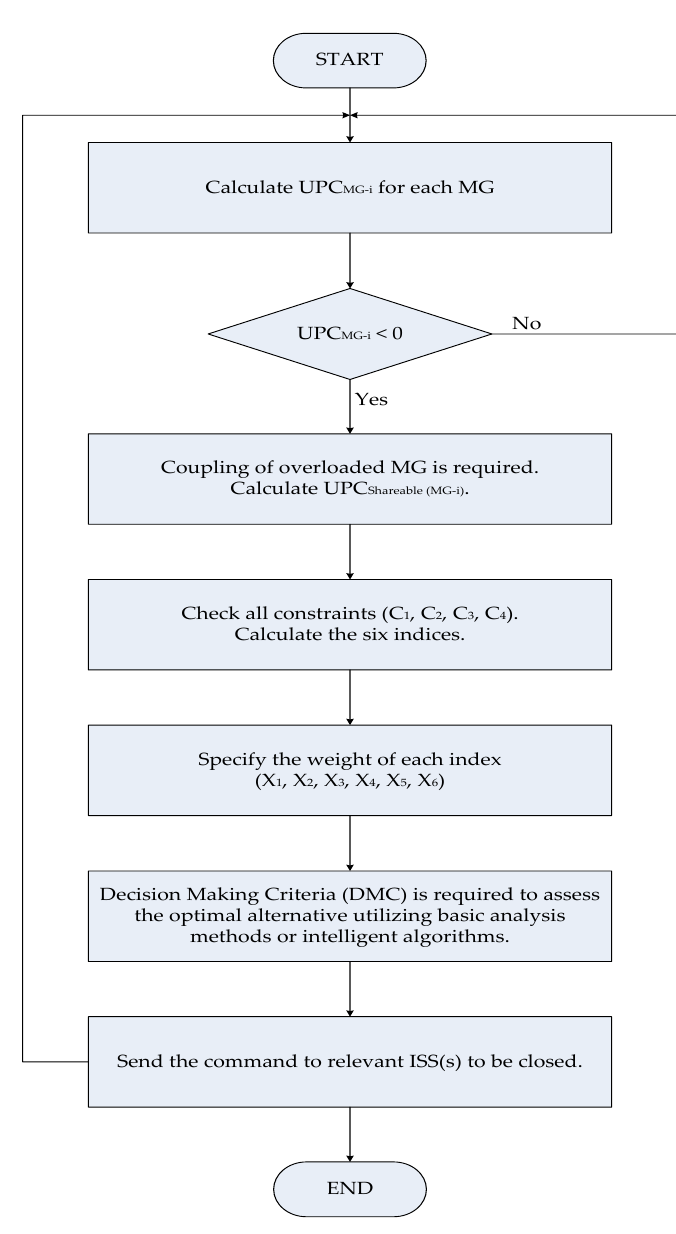
Figure 7. Flowchart for the decision-making algorithm.